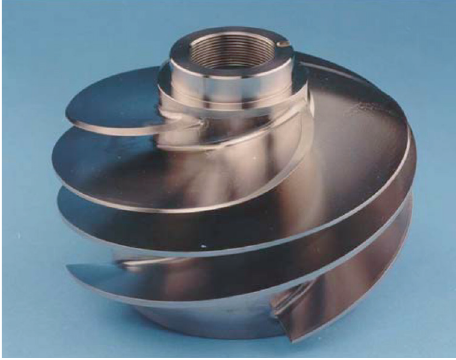
Figure 1: Inducer